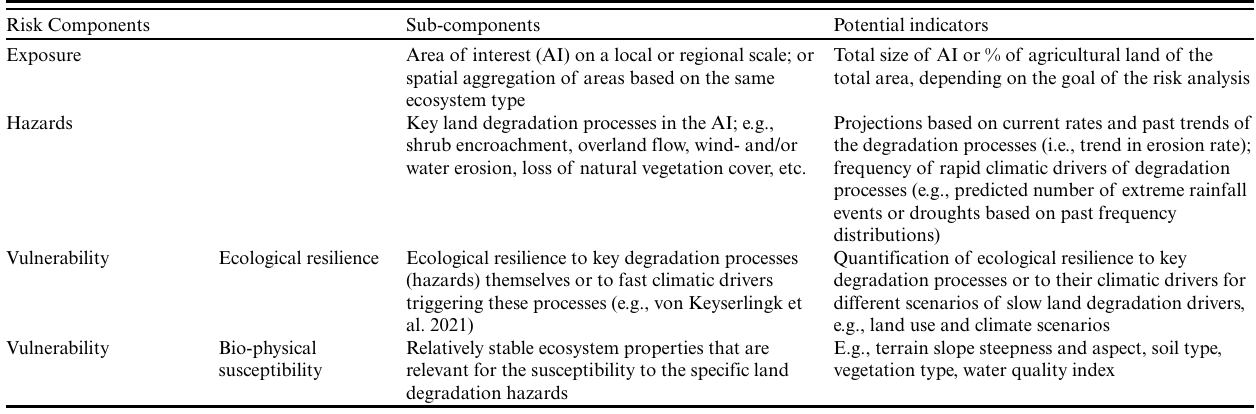
Table 2. Proposed identification of risk components and indicators for land degradation risk at ecosystem level, integrating the disaster risk framework of the United Nations Office for Disaster Risk Reduction. Table adapted from von Keyserlingk